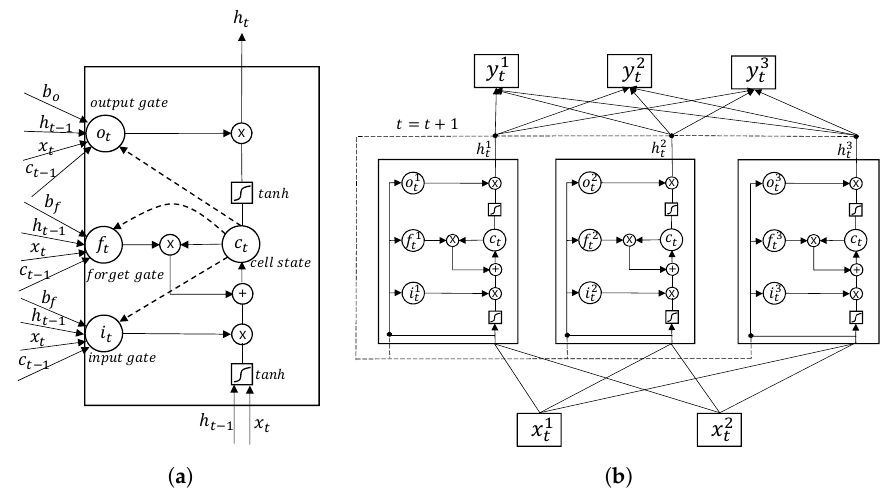
Figure 9. ( a ) LSTM Cell; ( b ) An architecture of LSTM